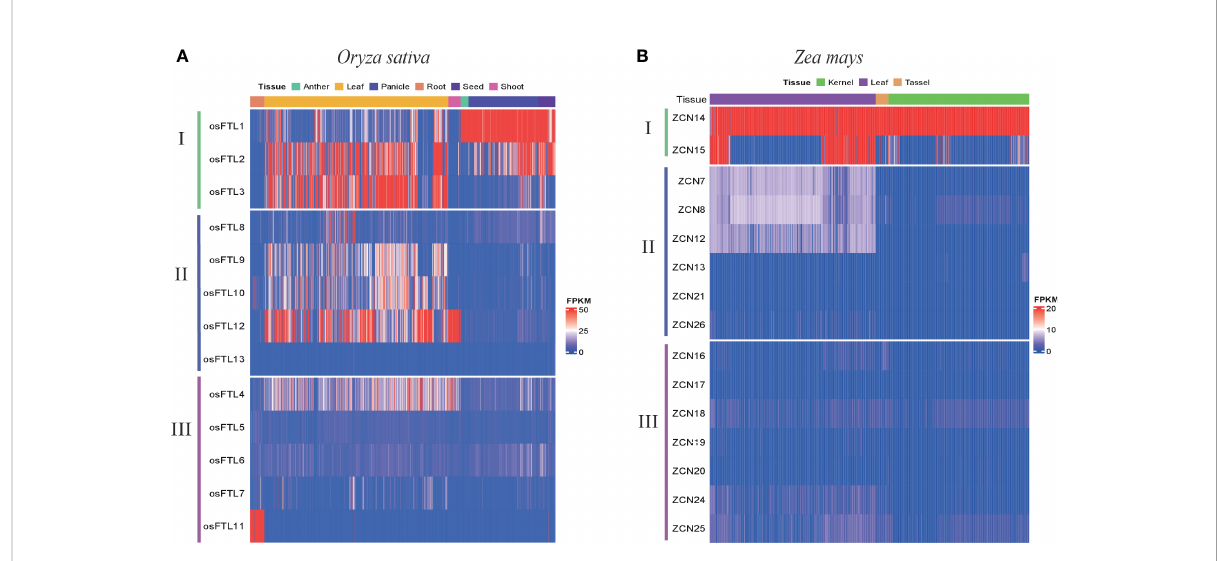
FIGURE 6 The expression patterns of the three clades ’ FT gene in two monocot species including (A) Oryza sativa and (B) Zea mays